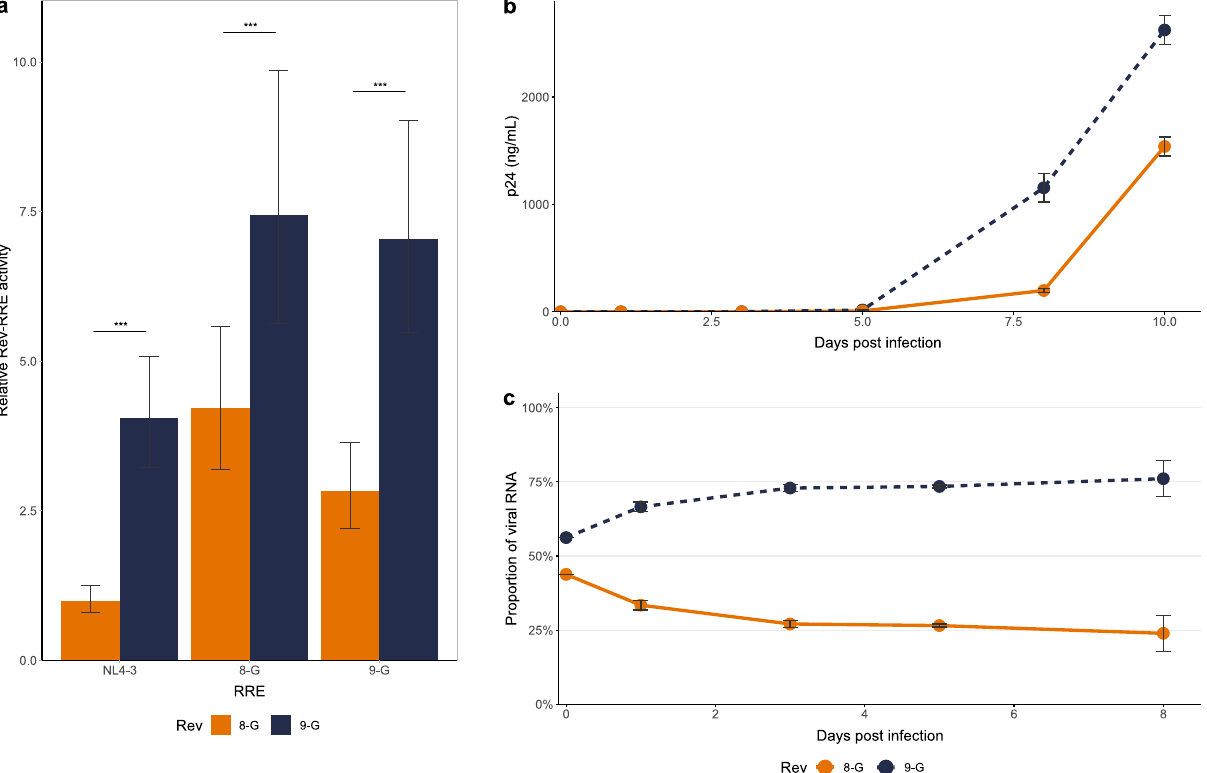
Figure 2. Relative activity of the 8-G and 9-G Revs. The activity of the Revs derived from the 8-G and 9-G primary isolates was determined via three complementary methods. ( a ) Rev-RRE activity was determined by a fluorescence-based assay utilizing lymphoid cells transduced with Rev- and RRE-containing reporter constructs. The relative activity of the 8-G and 9-G Revs was measured in conjunction with the NL4-3, 8-G, and 9-G RREs. Relative activity is expressed in arbitrary units with the activity of the 8-G Rev/NL4-3 RRE pair defined as 1. N > 3 for all comparisons, error bars represent 95% confidence intervals (CI), *** p < 0.001. ( b ) Replication- competent constructs containing the 8-G or 9-G Rev were used to infect parallel cultures of SupT1 cells. Infection kinetics were measured by determining the production of p24 protein in culture supernatants over time. N = 3 for each data point, error bars represent standard deviation (SD). ( c ) The relative replicative fitness of the replication-competent constructs assayed in ( b ) was also measured in a direct competition assay. Cultures of SupT1 cells were co-infected with 8-G and 9-G Rev containing viruses. The relative amount of 8-G Rev and 9-G Rev sequence in viral cDNA was determined at multiple time points, and expressed as the percentage of total Rev cDNA at that time point. N = 3 for each data point, error bars represent